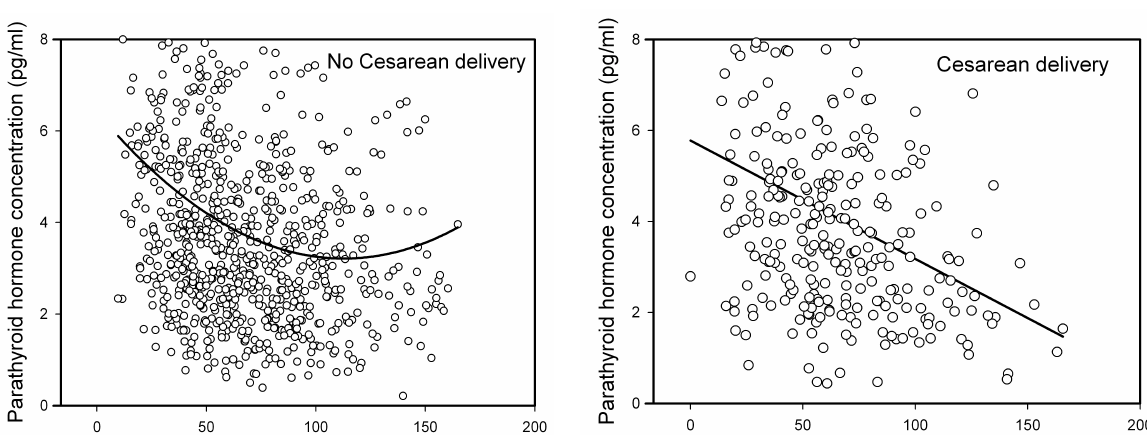
Figure 1. Serum 25-hydroxyvitamin D and parathyroid hormone in women without (left panel) and with (right panel) cesarean delivery. Data are unadjusted.